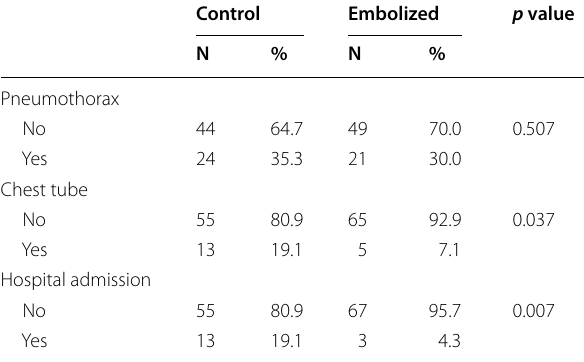
Table 3 Complication rates and sequel in both embolization group and